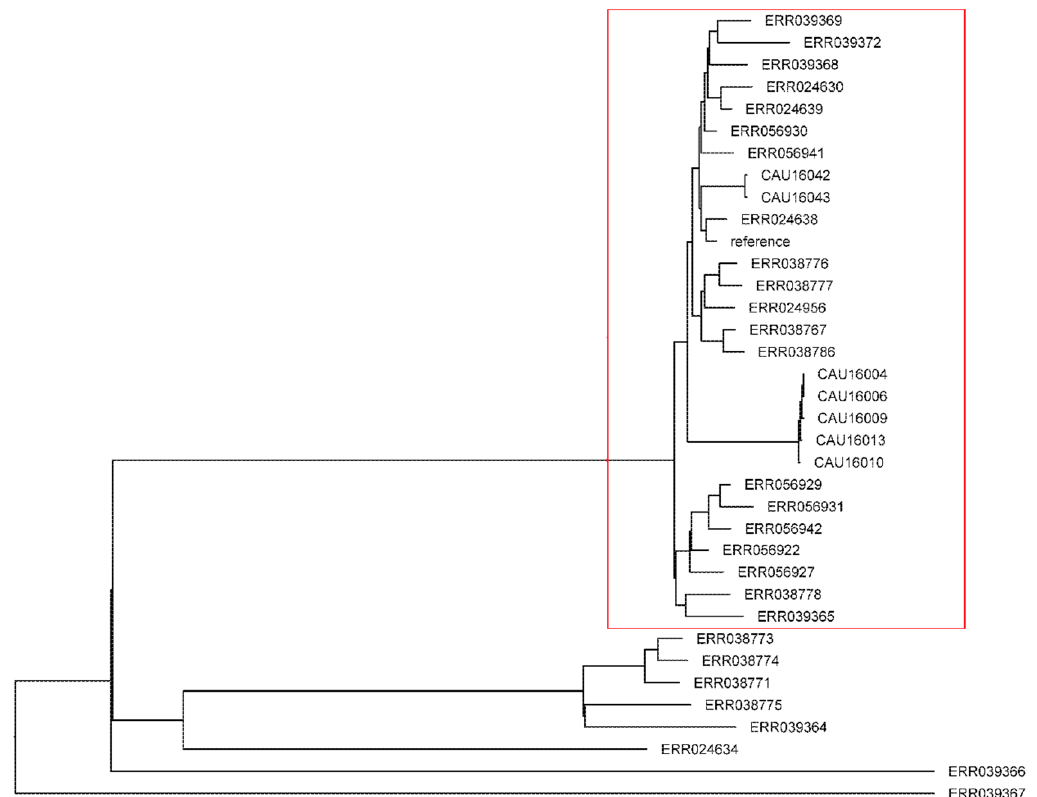
Figure 5. Phylogenetic tree obtained from SNP based phylogeny when SO4698-09 is used as reference strain. Red: Cluster 1 .